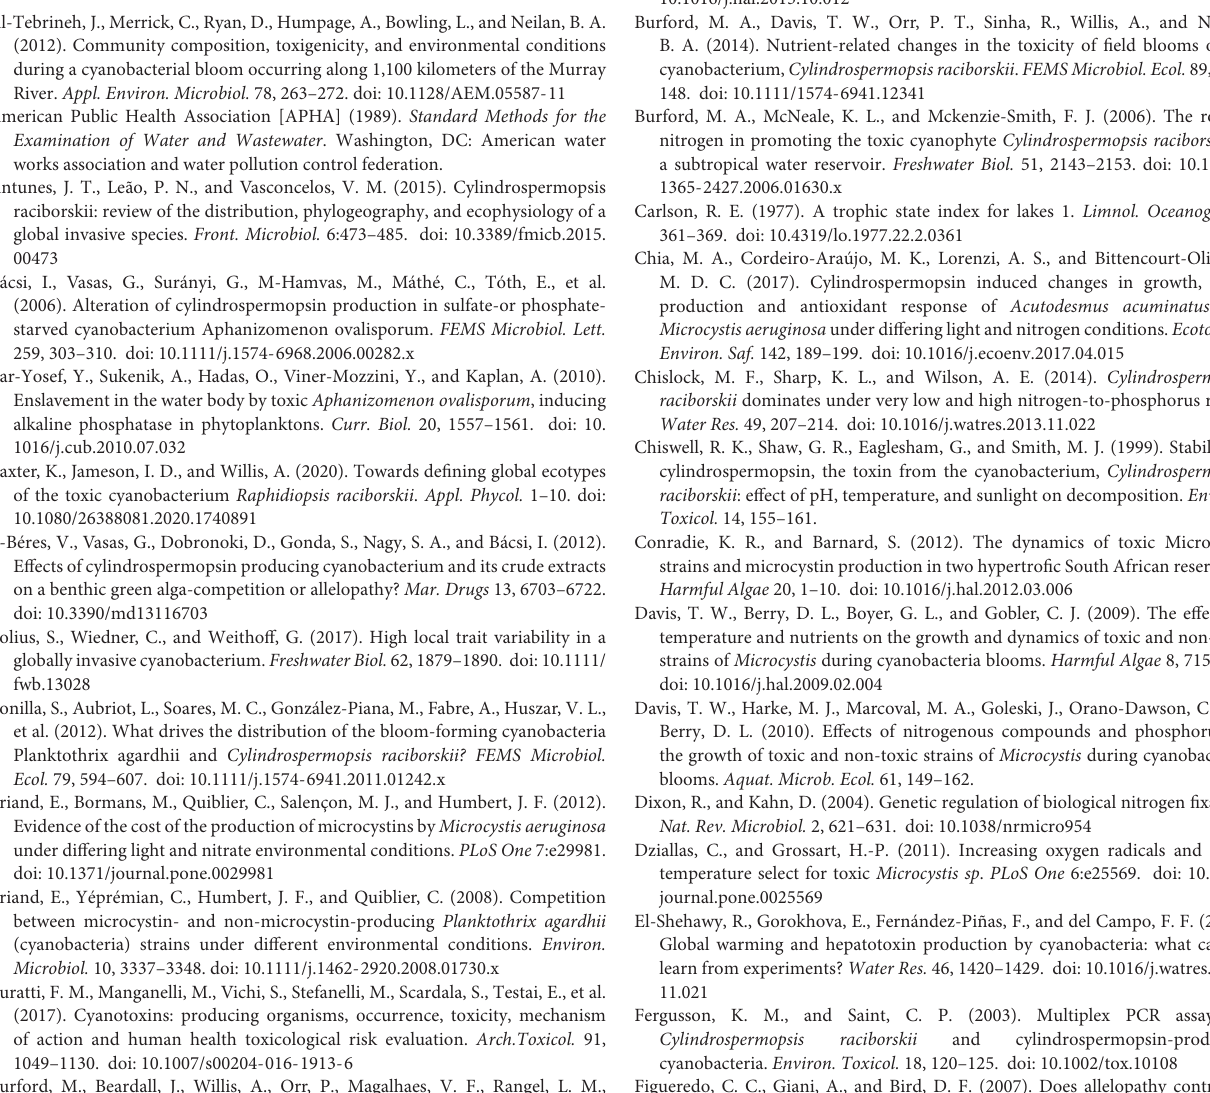
Figueredo, C. C., Giani, A., and Bird, D. F. (2007). Does allelopathy contribute to Cylindrospermopsis raciborskii (Cyanobacteria) bloom occurrence